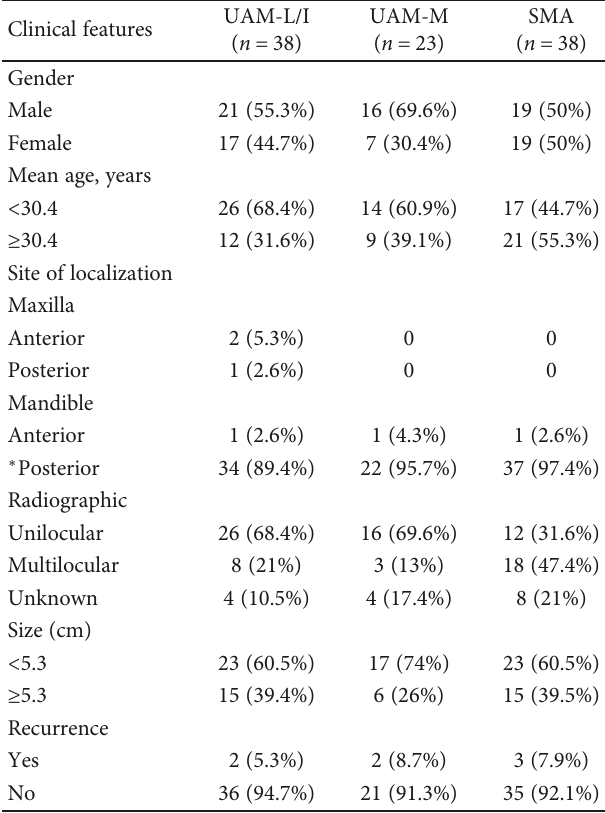
Table 1: Distribution of ameloblastomas according to clinical